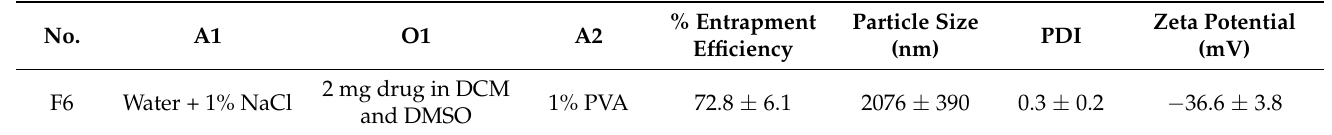
Table 1. Methods and physical characterizations of optimized formulation of Cela MPs (F6). Data represent mean ± SD (n = 3).